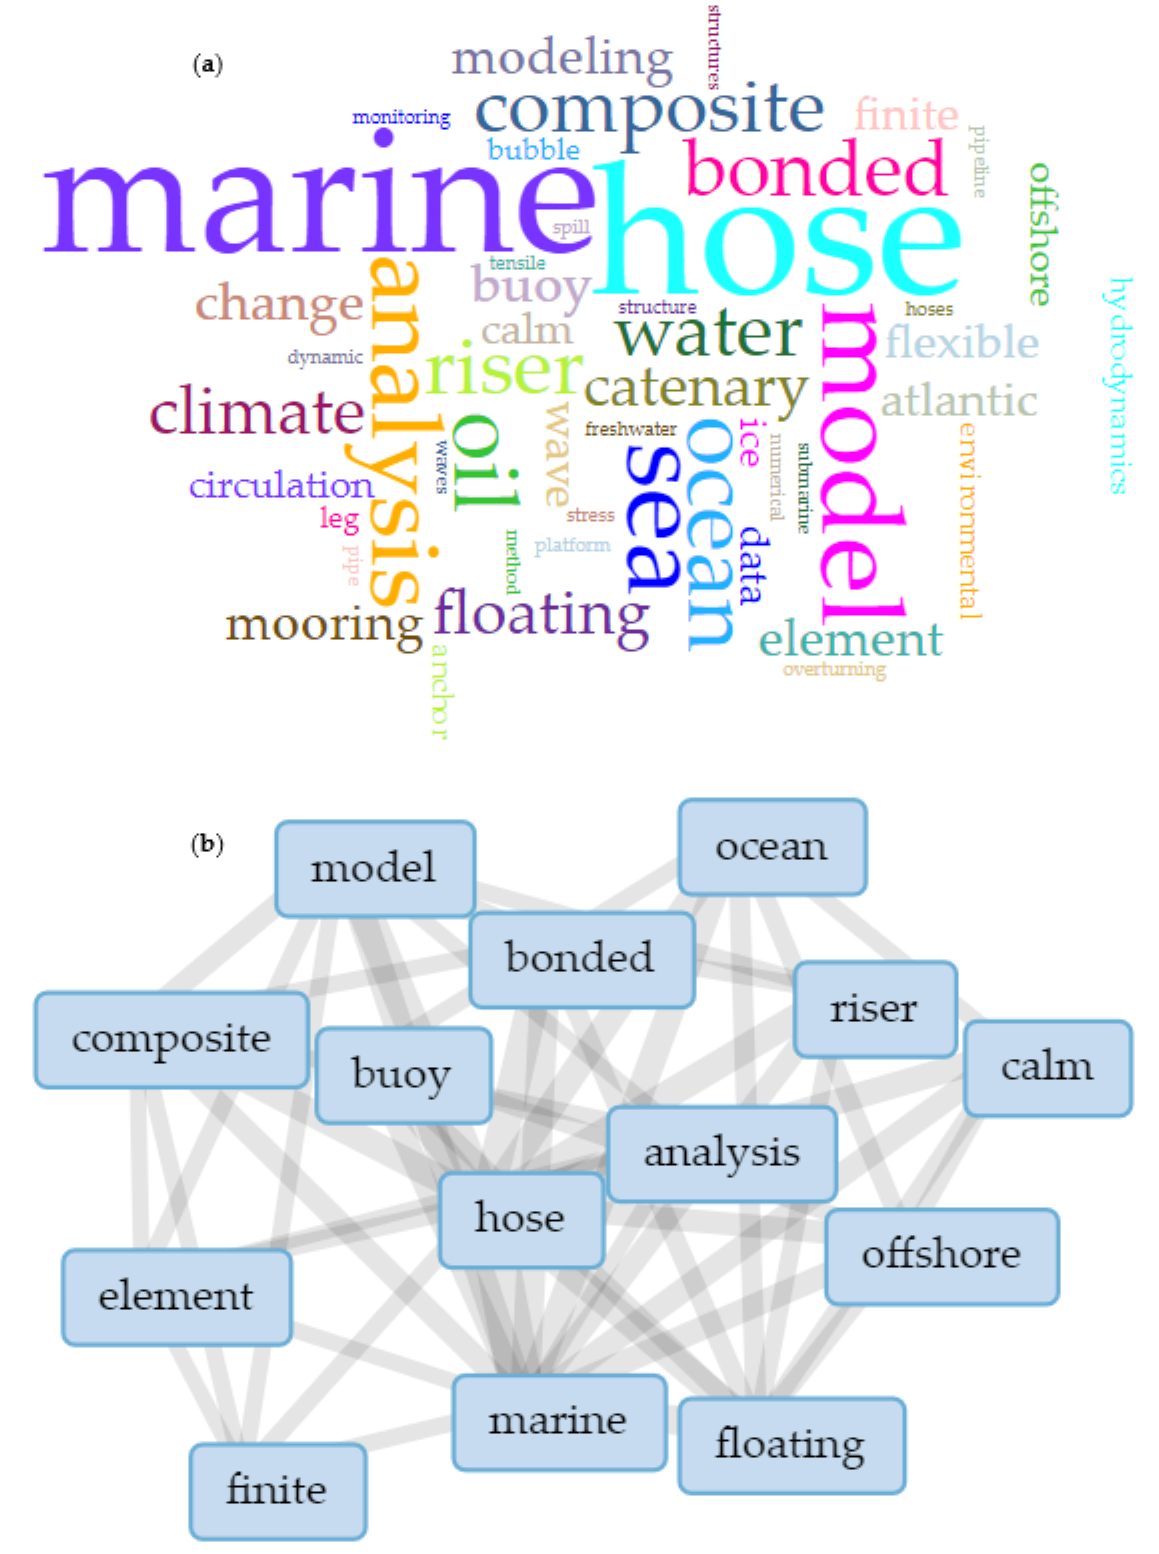
Figure 6. The word cloud for author keywords on “marine hose” research generated using Voyant word cloud generator, showing ( a ) the word cloud form and ( b ) the keyword links (data retrieved from Scopus database, 24 July 2022).